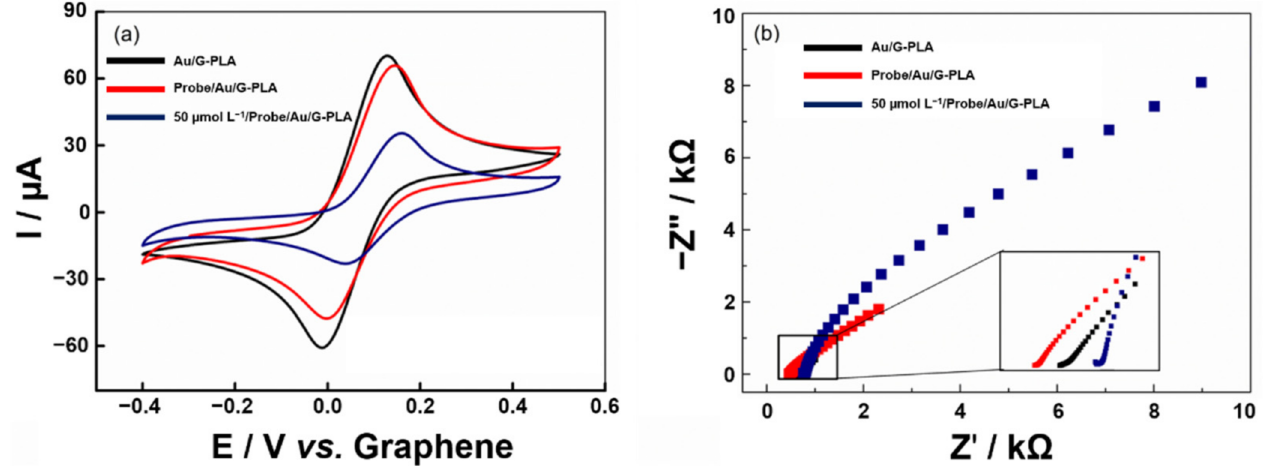
Figure 5. ( a ) Cyclic voltammograms and ( b ) Nyquist plots for each stage of sensor modification and af- ter hybridization, (black line) Au/G-PLA, (red line) Probe/Au/G-PLA, and (blue line) 50.0 µ mol L − 1 target sequence. All analyses were conducted using 1.0 mmol L − 1 ferrocenemethanol in 0.1 mol L − 1 KCl; CVs were carried out with a scan rate of 50 mV s − 1